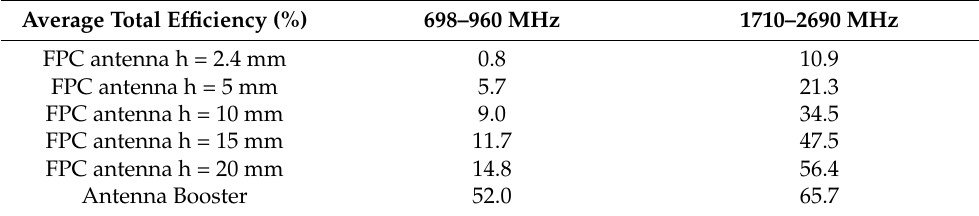
Table 2. Measured total efficiency for the FPC antenna and antenna booster.